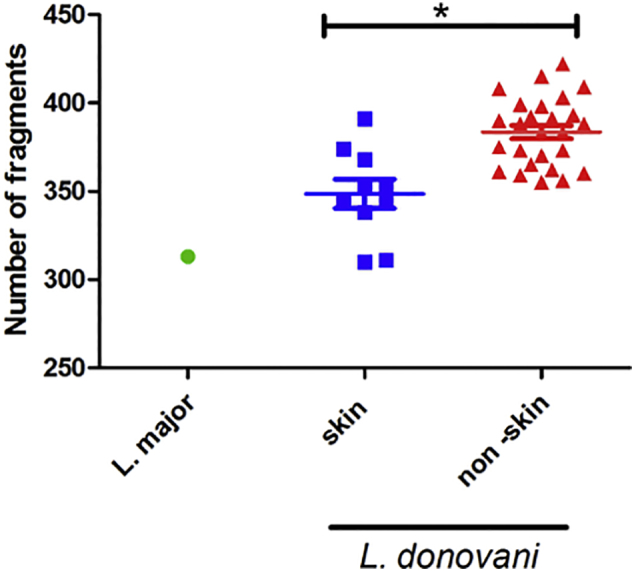
Number of AFLP alleles for skin and non-skin Leishmania strains. AFLP analysis using six selective primers was performed on 36 L. donovani and one L. major strains. The total number of polymorphic AFLP fragments was plotted according to tissue from which strain was cultured. Skin: 10 strains were isolated from the skin of northern Ethiopian HIV/VL and Sudanese PKDL patients. Non-skin: 26 strains were isolated from the spleen, bone marrow and lymph nodes of VL and HIV/VL patients from Sudan and Ethiopia. Skin isolates (average 10 strains = 348.6 ± 8.1), VL strains (average 26 strains = 383.5 ± 3.8). *unpaired t-test, p < 0.0001.